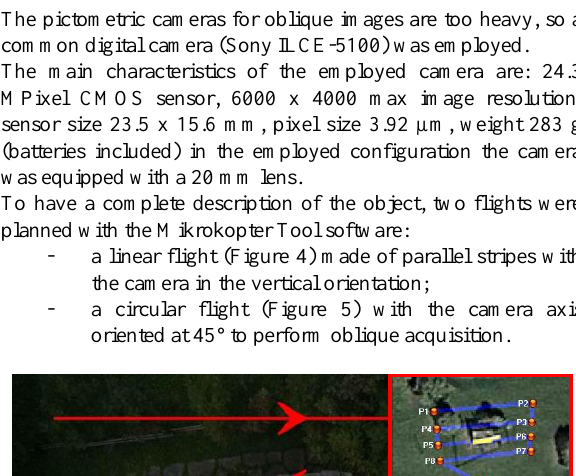
Figure 3. The employed multi-rotor platform used for the image acquisition